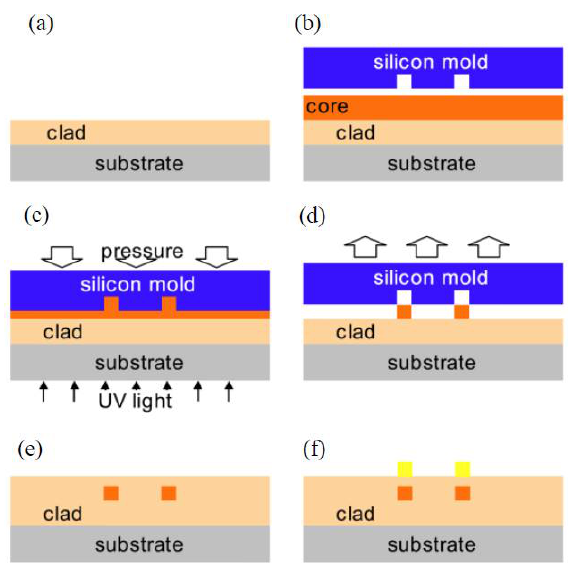
Figure 21. UV imprinting steps for integrated waveguide VOA-based on polymer materials. ( a ) Spin-coating and curing for under-cladding; ( b ) core material dispensing; ( c ) imprinting under pressure with UV irradiation; ( d ) detachment of the mold; ( e ) spin-coating and curing for cover-cladding; and ( f ) TO electrode patterning [74]. Copyright 2006 Elsevier.